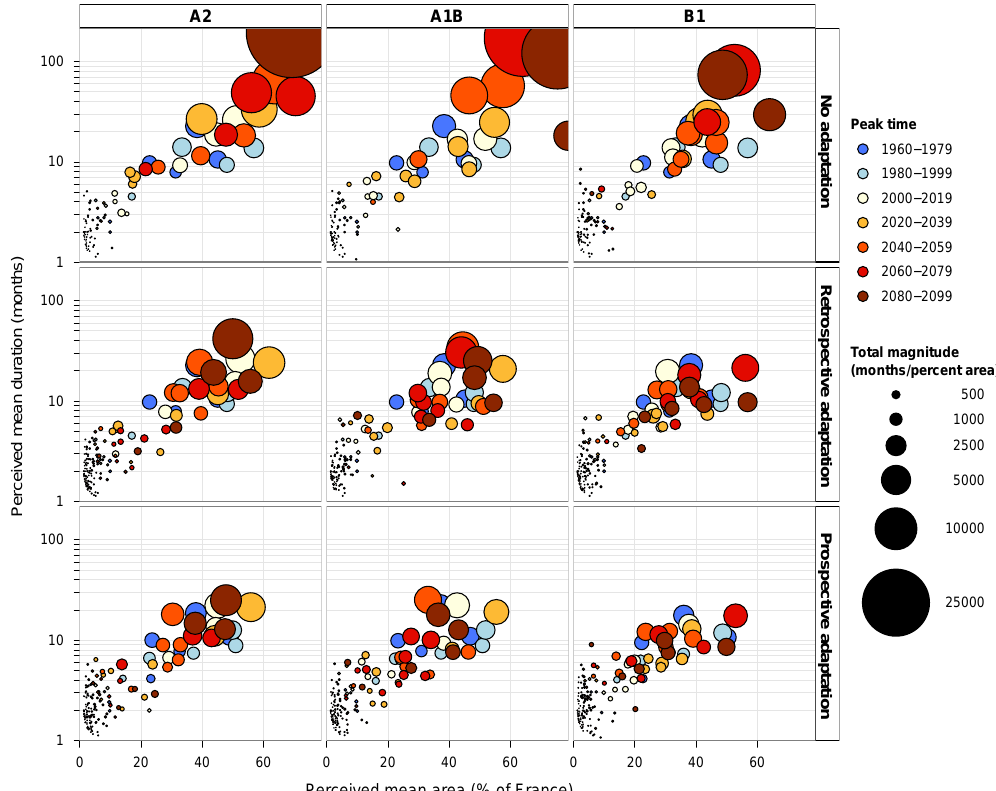
Fig. 8. As for Fig. 7, but for long meteorological droughts, as defined by SPI12.